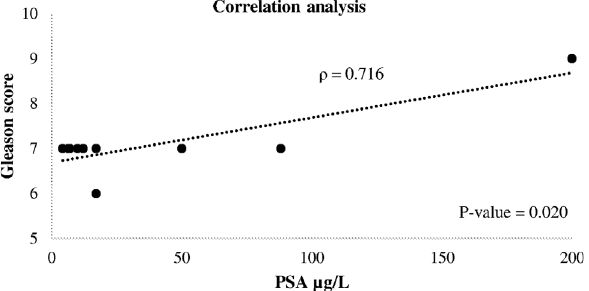
Figure 1 - Correlation between levels of serum PSA and Gleason score. The correlation coefficient of 0.716 with p -value < 0.05 indicates that se- rum PSA was moderately correlated with Gleason score.